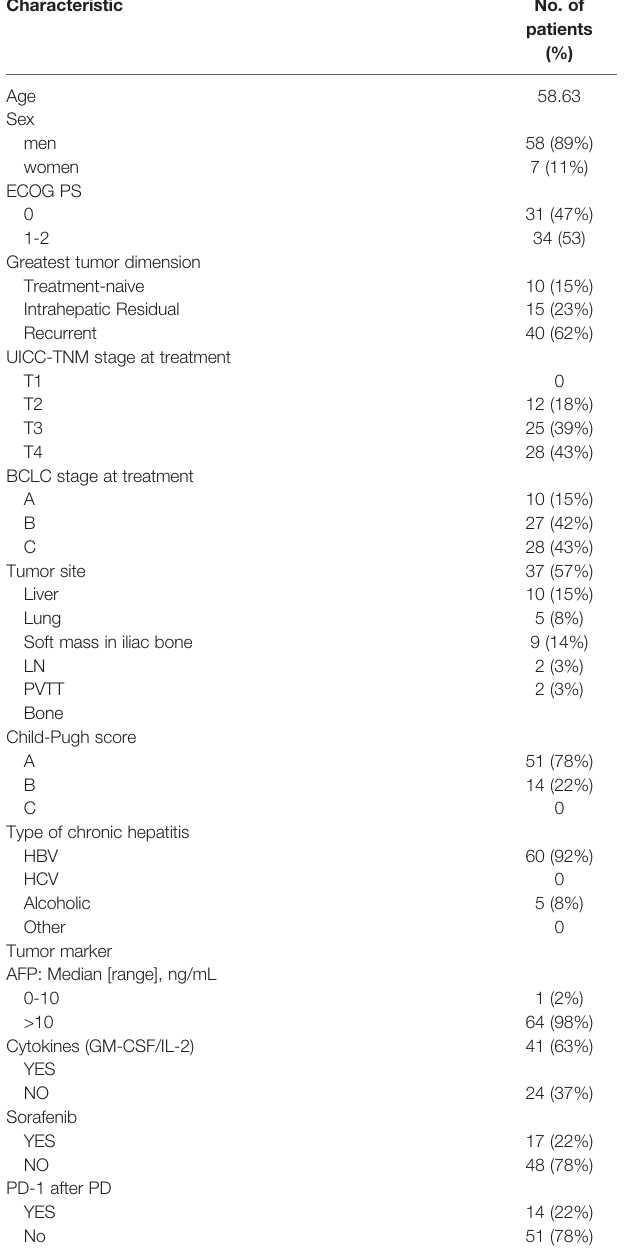
TABLE 1 | Patient characteristics.